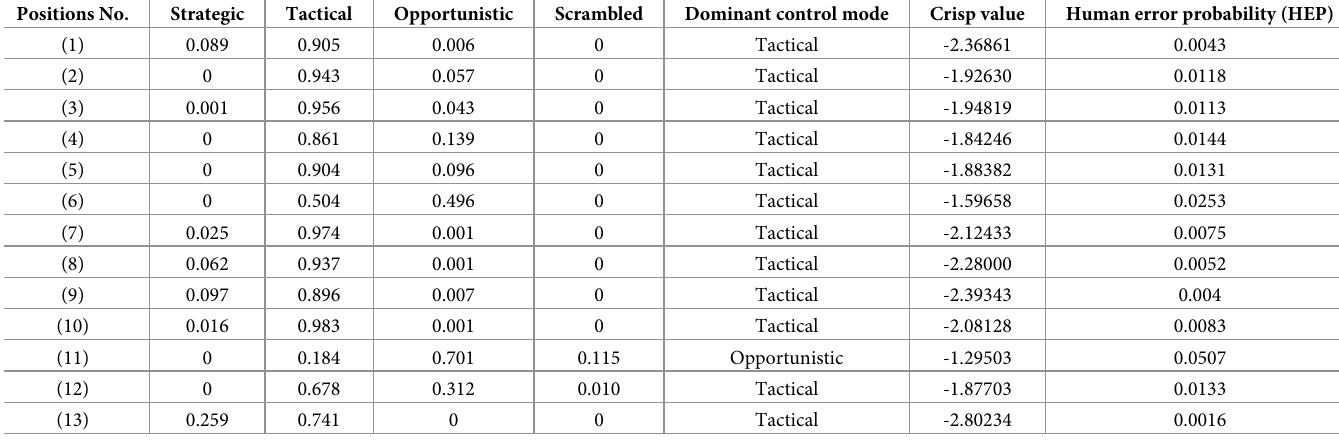
mode of operator in job position 11 was opportunistic, indicating that the probability of opera- tor error was moderately high. To name the main reasons, the operator did not implement the standardized operational requirements (nonstandard operation), was in a wrong operation position, and the labour protection equipment was not fully worn. The rest of the study calcu- lated the reliability of control mode for the operator of tactical, while control mode of the remaining job positions was Tactical, and Human error probability (HEP) ranking can be obtained at the same time. The job positions in the order of the error probability of the workers are (6), (4), (12), (5), (2), (3), (10), (7), (8), (1), (9), and (13), as shown in Fig 5. Analysing monthly human error times at different positions in an enterprise showed that the trend was basically identical, which proved that our proposed model was reasonable and had a certain practical significance. For comparison purposes, taking operation 1 and operation 11 as an example, the basic CREAM [29] are investigated (on the basis of the same input), as can be seen in Table 7, the results of the proposed quantified methodology are in the range of the expectations of Table 6. Control mode and reliability probability value of different operating positions. Positions No.